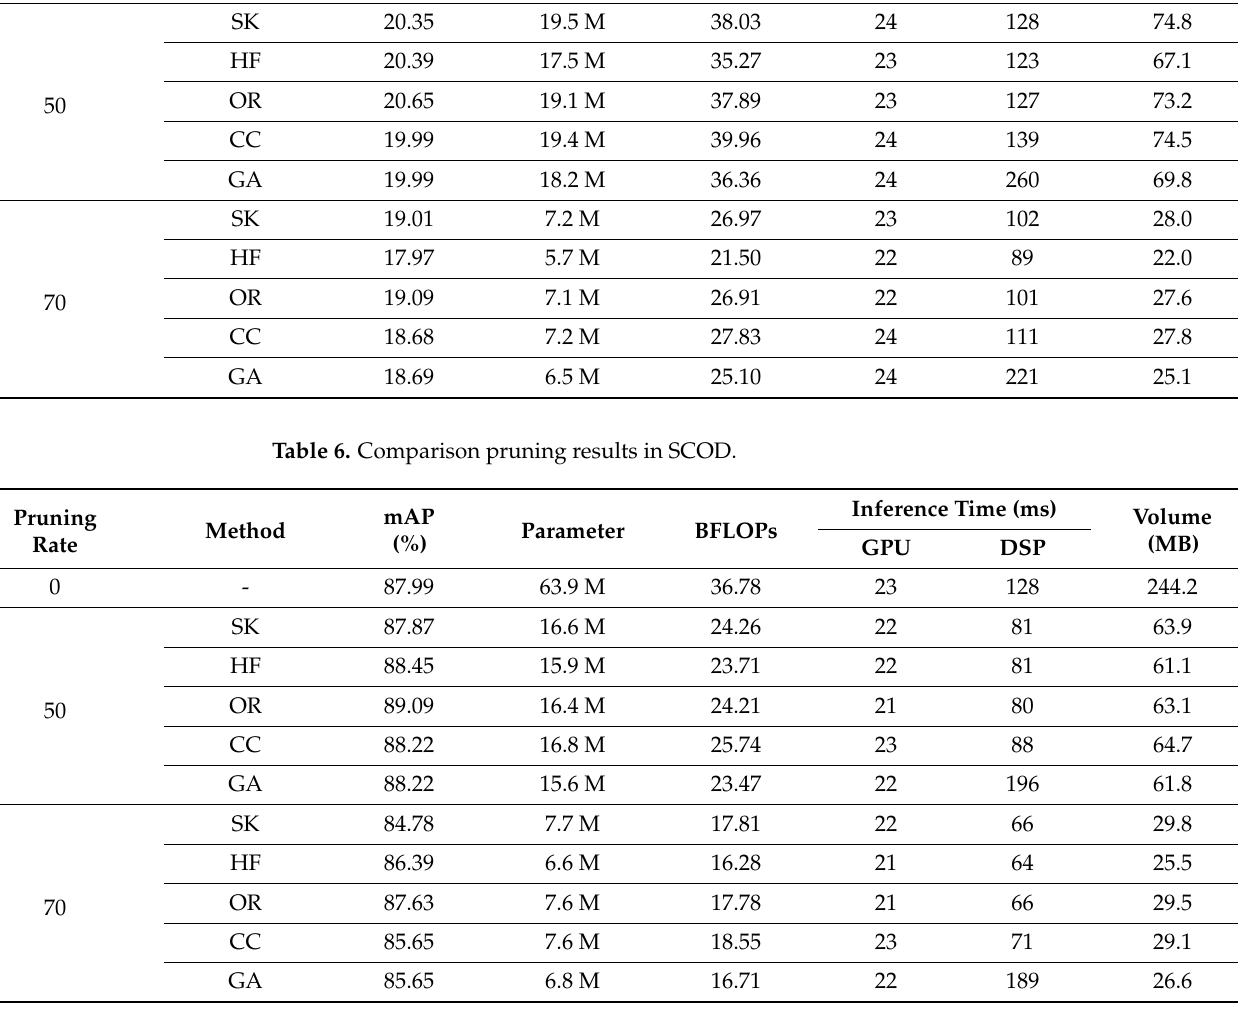
Figure 15; Figure 16 show the detection results in VisDrone-DET2019 and SCOD, respectively. In Figure 15; Figure 16, the left pictures show the detection results of the original YOLOv4 and the right ones show the detection results of the YOLOv4 ported to QCS605 through the simplification and the quantization. For the simplification of YOLOv4, 70% of the channels were pruned using the OR method. Although the pruned network missed a few small objects in VisDrone-DET2019, the detection performance of the pruned network was very close to that of the original, even though 70% of the channels were